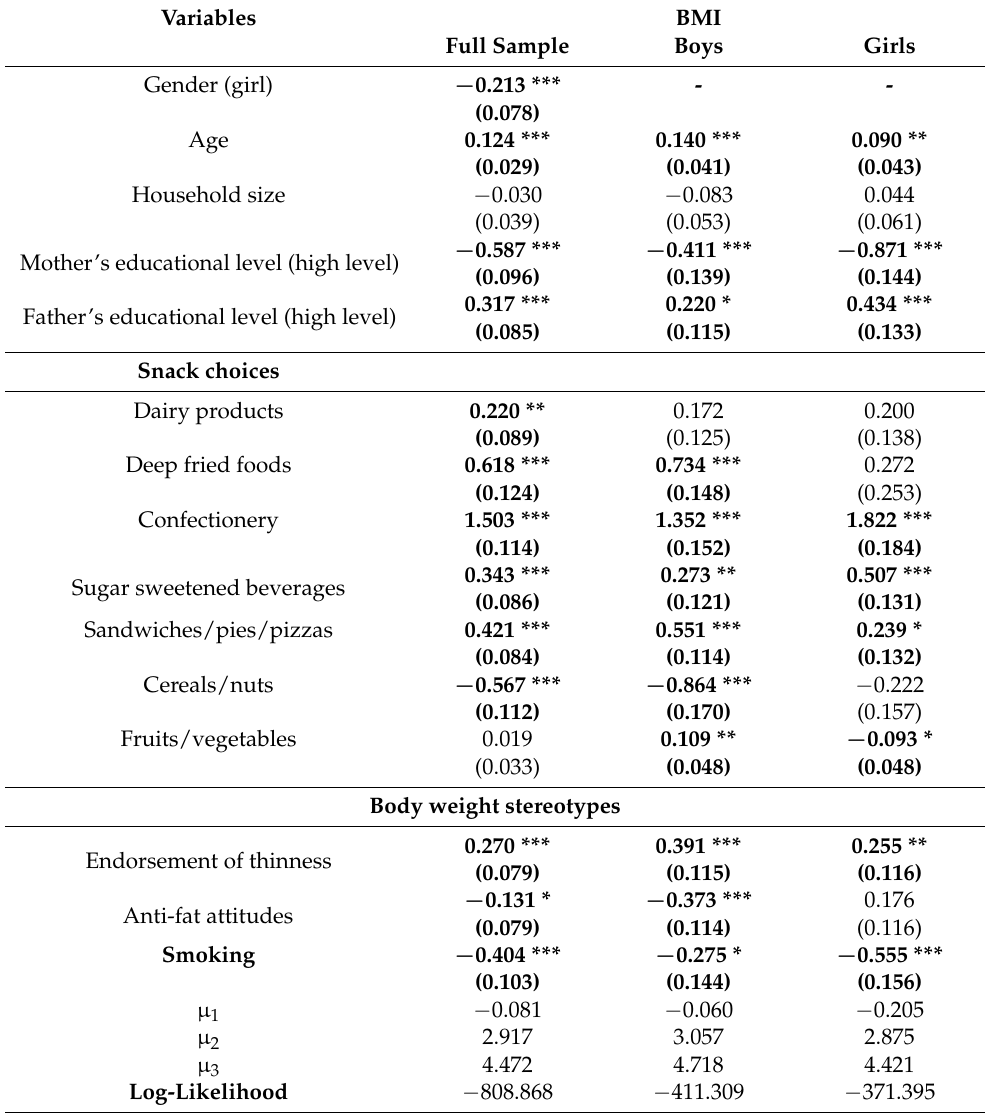
Table 3. Adolescents’ BMI estimates of the univariate ordered probit